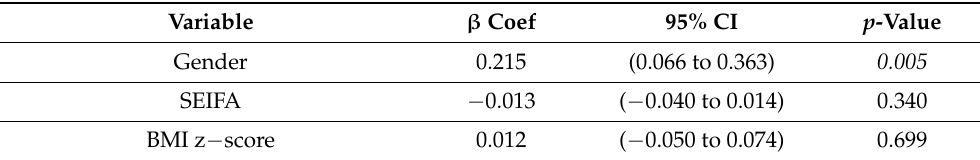
Multivariate linear regression coefficients of outcome variables and total YFAS-C symptom